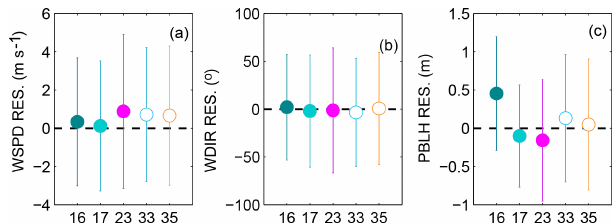
Figure 12. Residual (model–data mismatch) mean and standard de- viation of individual members for wind speed (a) , wind direction (b) and PBLH (c) using the SA- and GA-calibrated sub-ensemble of five